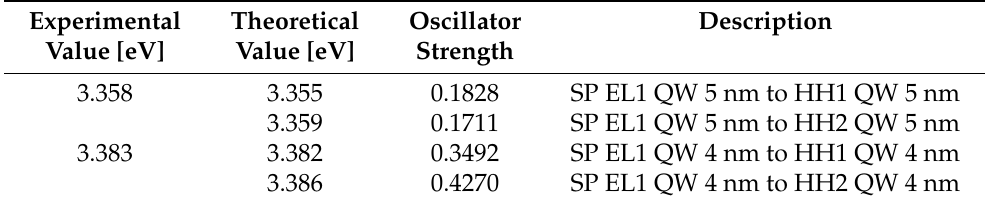
Table 1. Single particle (SP) energy transitions, oscillator strength both calculated in 8 k·p model and corresponding experimental values for structure #1: 2 QWs with widths 5 and 4 nm and 12 nm barrier between them.